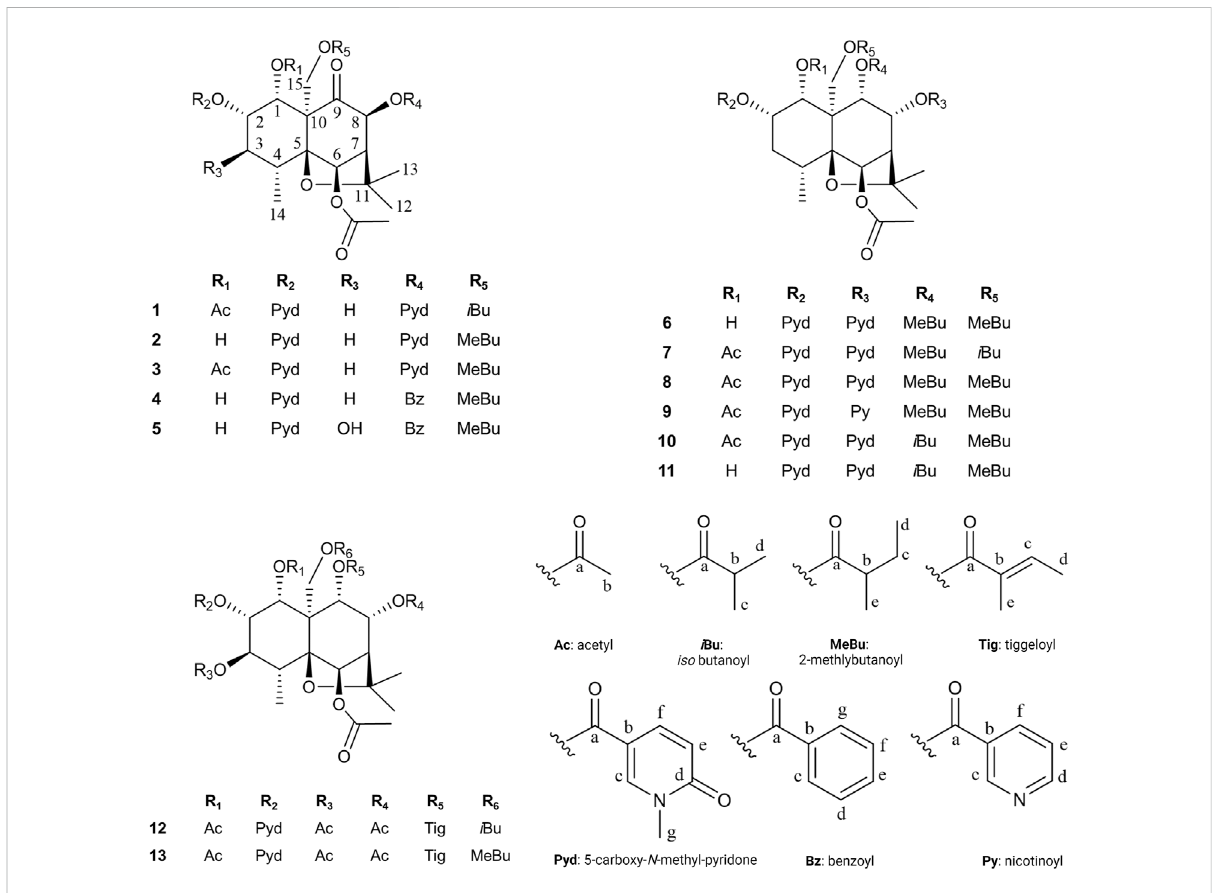
FIGURE 3 Original dihydro- β -agarofuran derivatives isolated from the Pristimera indica roots